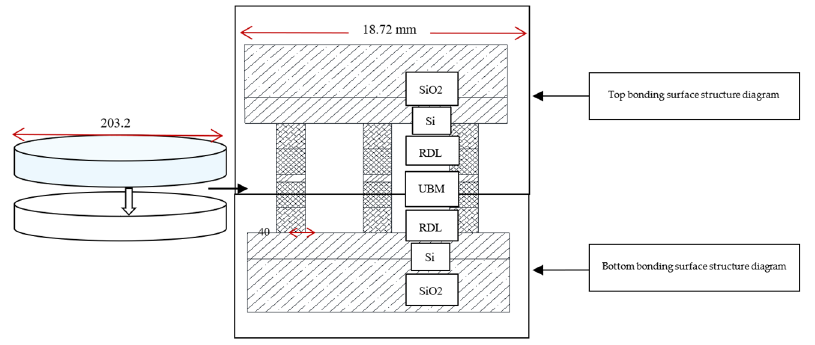
Figure 2. Wafer with only bumps and daisy chain partial layout (quarter of the die, the green bumps in figure are the superposition of RDL and UBM).